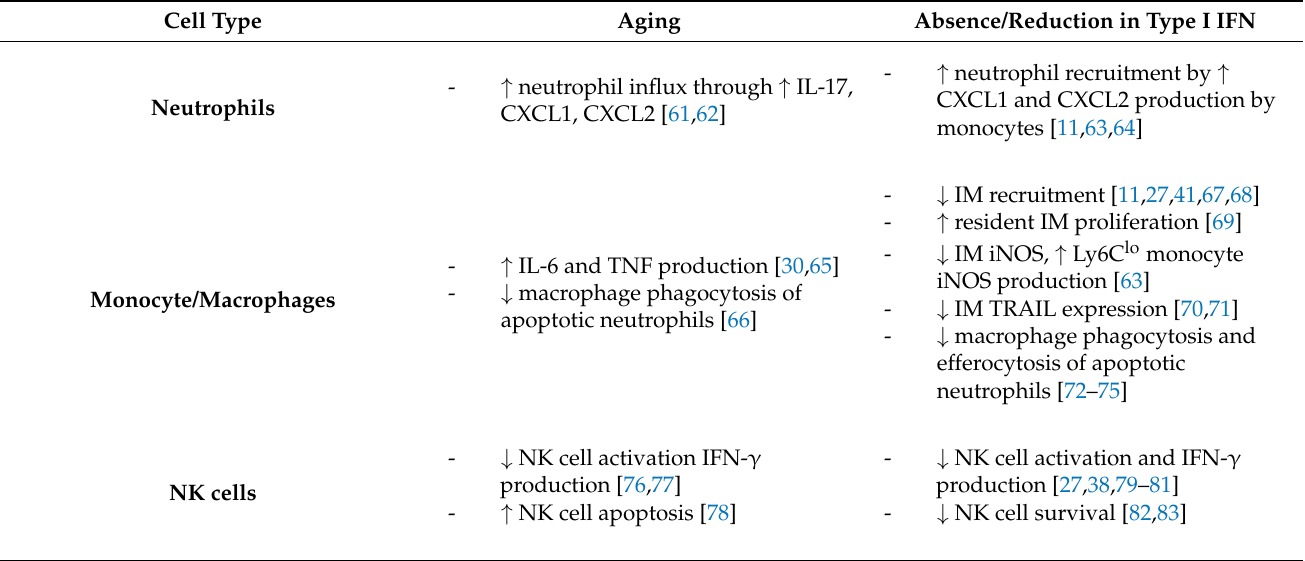
Table 1. Comparison of changes in innate immune responses in aging and the absence of type I IFN. Cell